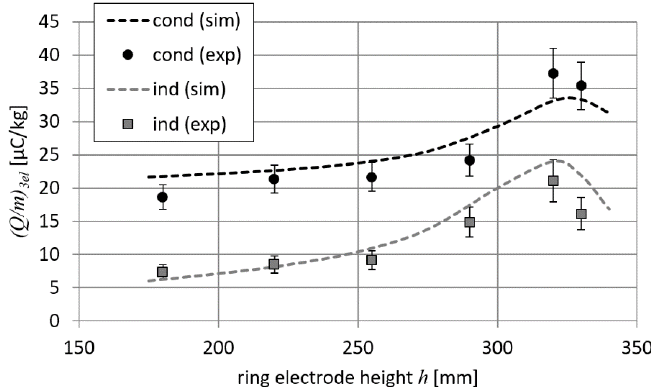
Figure 12. Measured (“exp”) and calculated (“sim”) ( Q / m ) 3 el parameter values for both electrification methods in the 3-electrode system, as a function of the ring electrode height h .